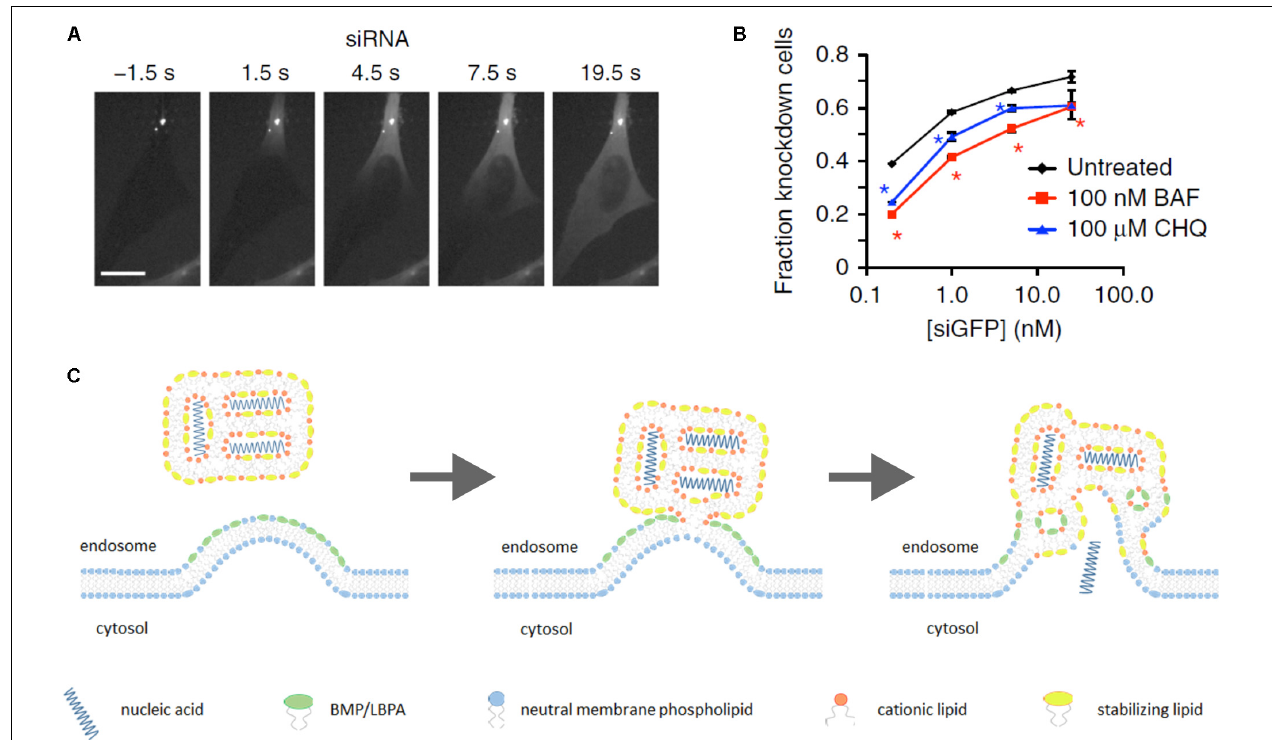
FIGURE 2 | Lipoplex endosomal escape. Escape of lipoplex-formulated genetic cargo from an endosome in HeLa cells takes seconds followed by diffusion of siRNA throughout entire cytosol (A) . Efficacy of GFP knockdown in HeLa-GFP cells upon incubation with lipoplexes carrying siGFP in the presence of inhibitors of endosomal acidification bafilomycin A1 (BAF) or chloroquine (CHQ) (B) . “Lipid-mixing” mechanism of endosomal escape of lipoplex-formulated nucleic acids in assumption of primary role of BMP/LBPA, concentrated in the luminal leaflet of endosomal membrane in area of ILV formation (see the text for additional comments) (C) . (A,B) Figures are reprinted by permission from Nature Publishing Group (Wittrup et al.,